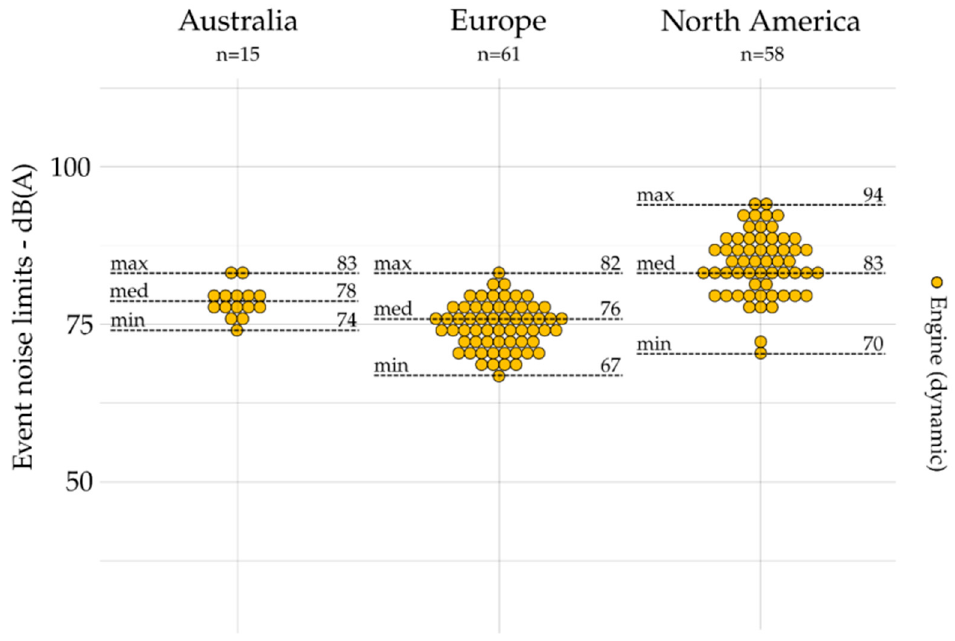
Figure 6. Event indicators for emission (i.e., engine) and grouped by geographic area ( n = 134).